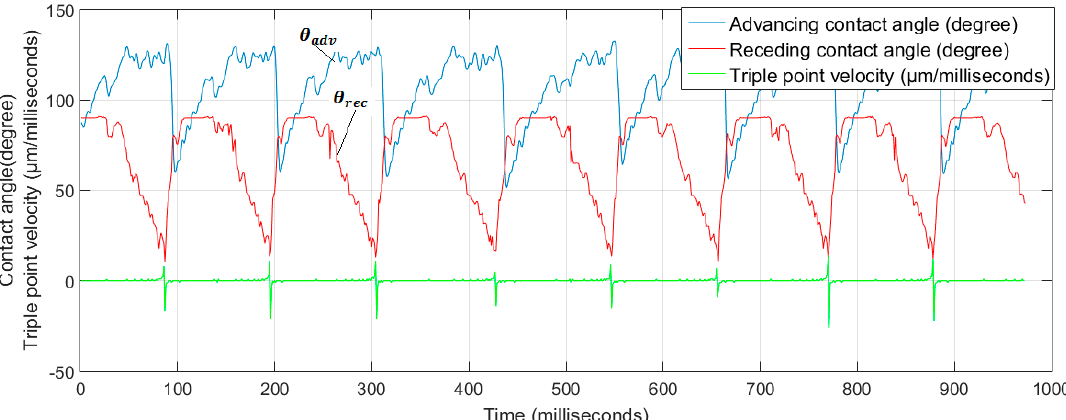
Figure 20. Advancing (blue line) and receding (red) contact angles and triple-point velocity (black) versus time for nine droplet flow formation cycles for J (cid:96) = 0.0067 m / s, J g = 10 m / s.